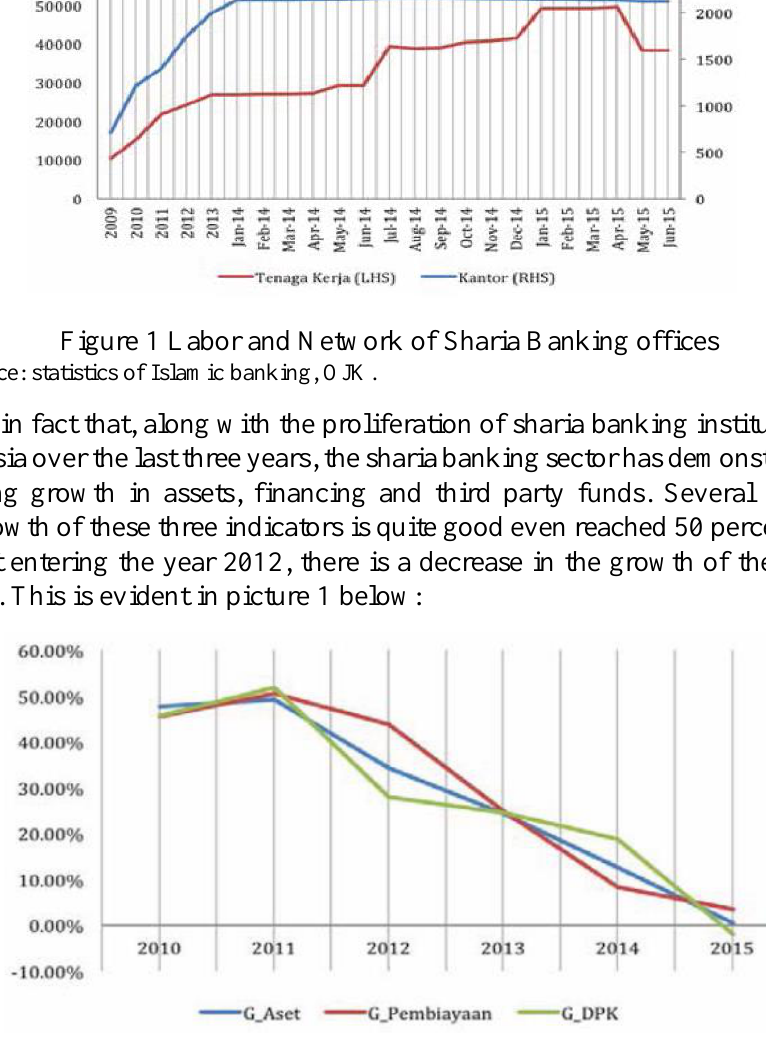
Figure 2 The growth of sharia banking